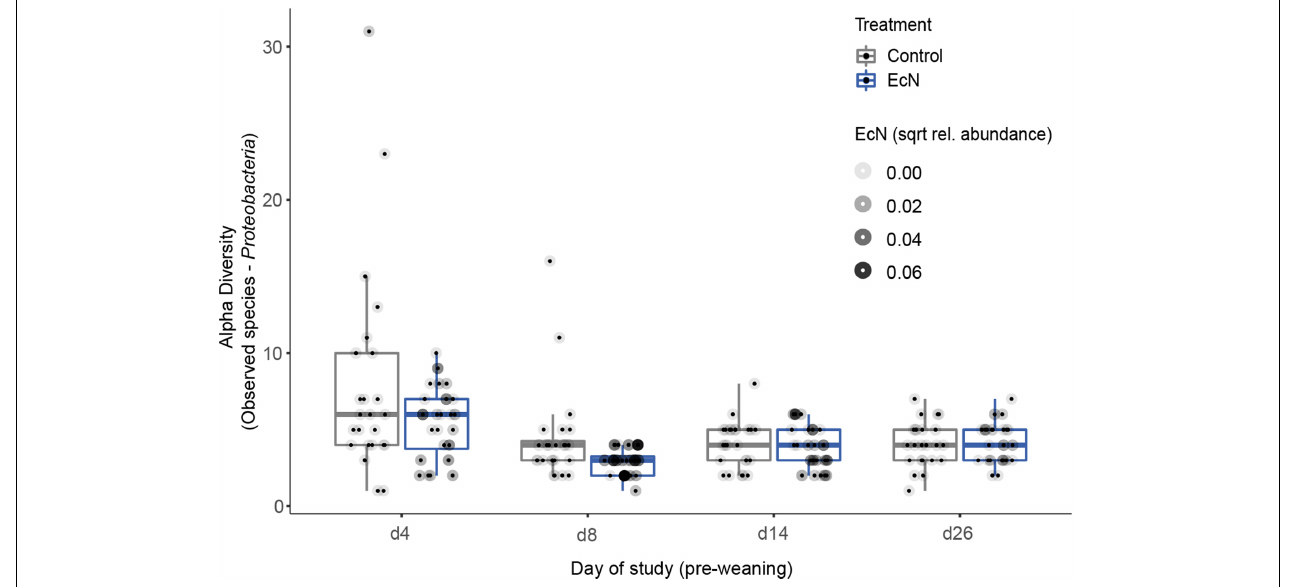
FIGURE 3 | Comparison of the number of observed ASVs in the Proteobacteria phylum in fecal samples between treatments and over time (pre-weaning). Every point represents a single animal within the control group (gray box) and the treatment group (blue box). Observed Species richness values are given by sampling time point (d4–26). A significant difference in the amount of Proteobacteria ASVs was found when including only pre-weaning time points. For each sample, the relative abundance of the EcN-specific ASV is visualized by tinting the outer circle (a darker tint means a higher abundance of